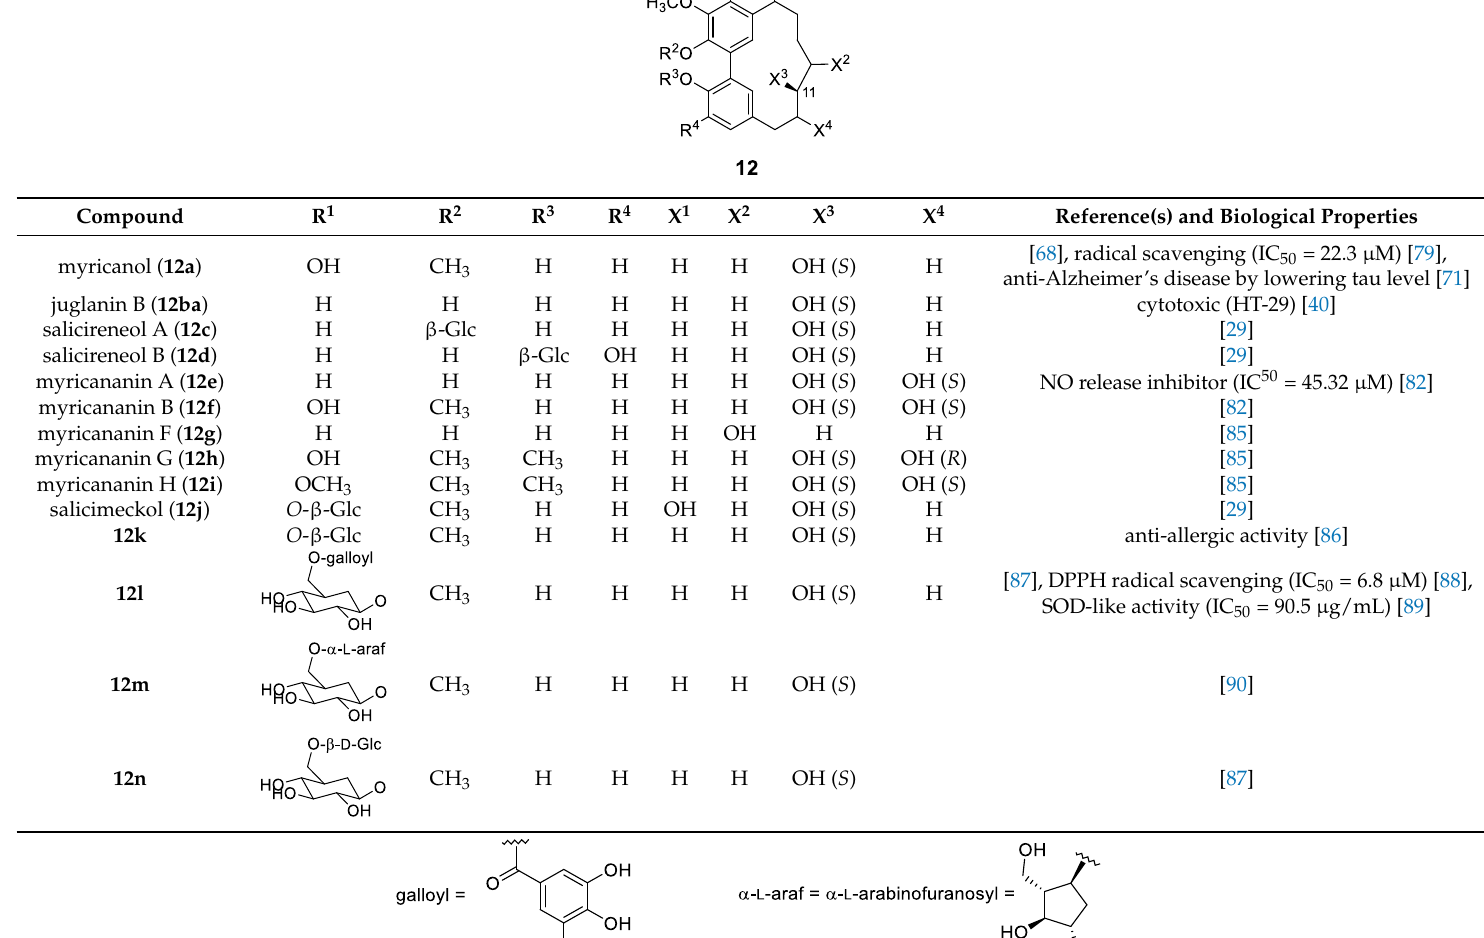
Table 4. The derivatives of myricanol ( 12a ) and their biological properties.